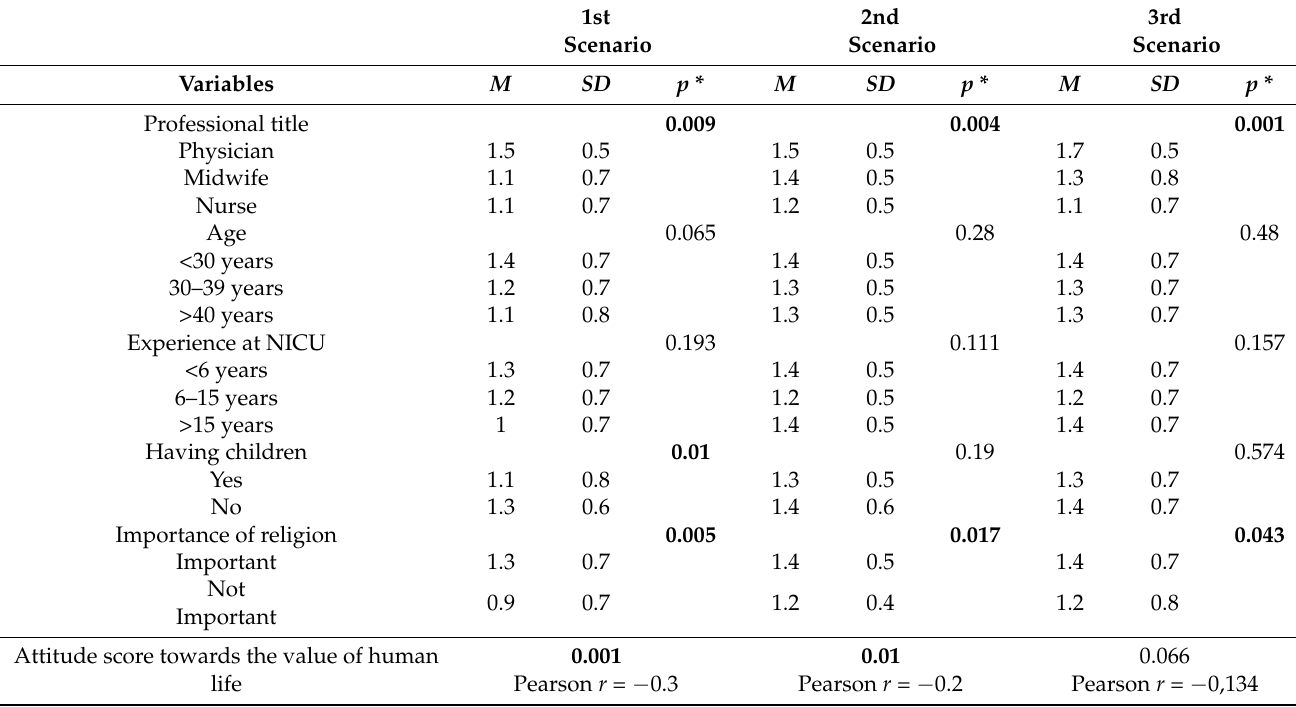
Table 3. Univariate analysis of the relationship between demographic and professional characteristics and therapeutic intensiveness (healthcare professionals declared intended behavior) expressed as the summary score from answers to three clinical scenarios per clinical